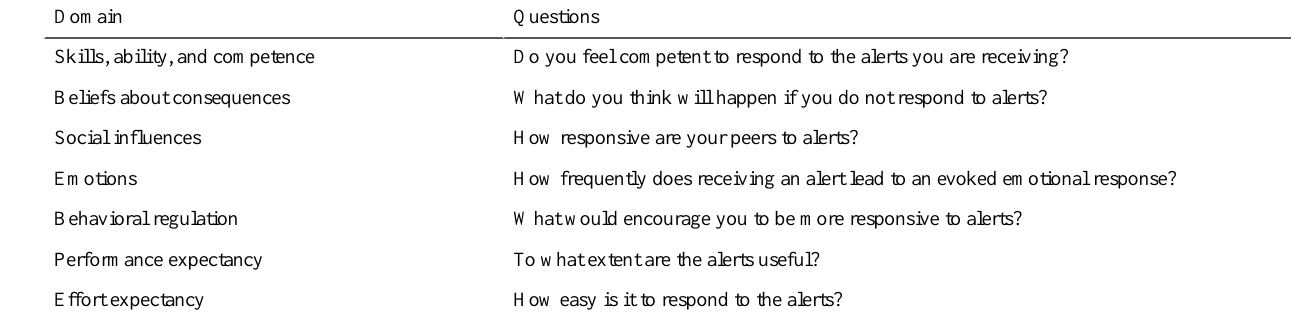
Table 4. Example 2